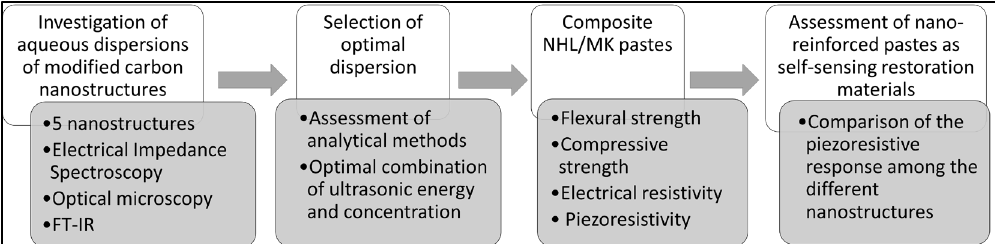
Figure 1. Schematic experimental process of the present study.